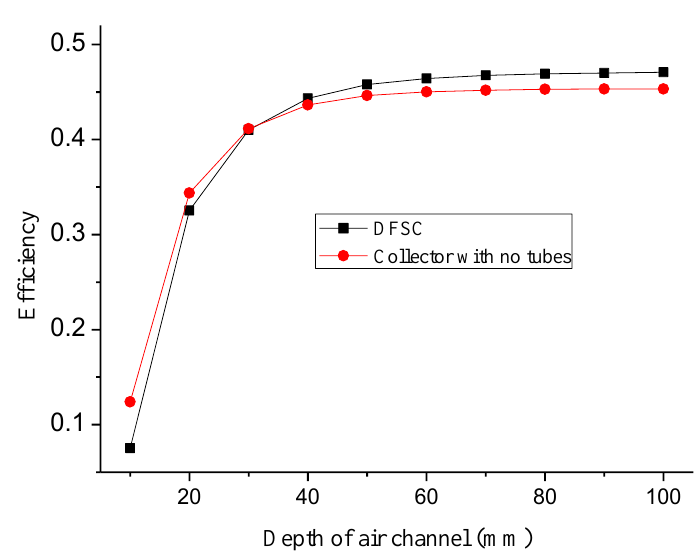
Figure 16. Effect of the air channel depth on the daily average efficiency.